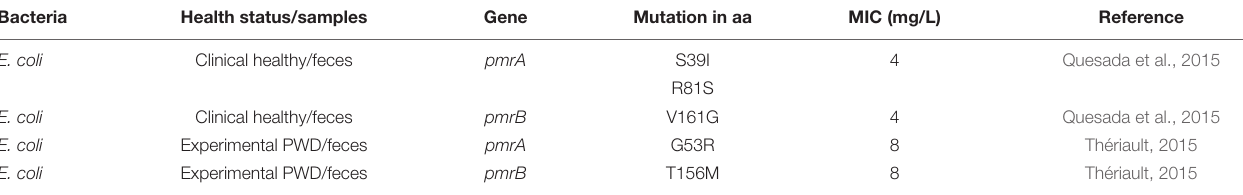
TABLE 5 | Mutations in two-component systems conferring resistance to colistin in E. coli of pig origin. Bacteria Health status/samples